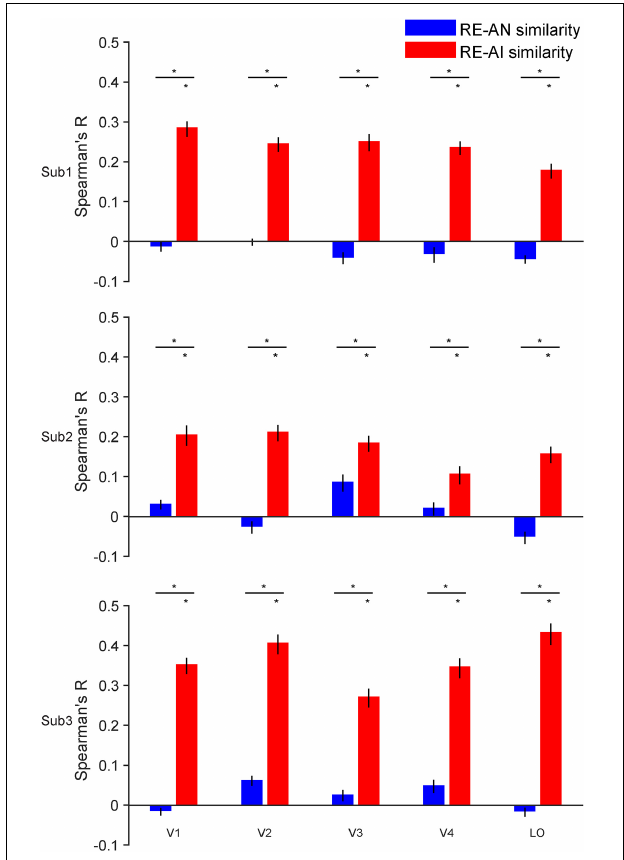
FIGURE 3 | RE-AI and RE-AN similarities in the human brain. Three subplots indicate the three human subjects. In all five brain ROIs, the RE-AI (red bars) similarities are substantially higher than the RE-AN (blue bars) similarities. Error bars are 95% confidence intervals of similarity values by bootstrapping vertices in one brain ROI (see Methods). The black asterisks above bars indicate that the similarity values are significantly different from null hypotheses (permutation test, p < 0.05, see